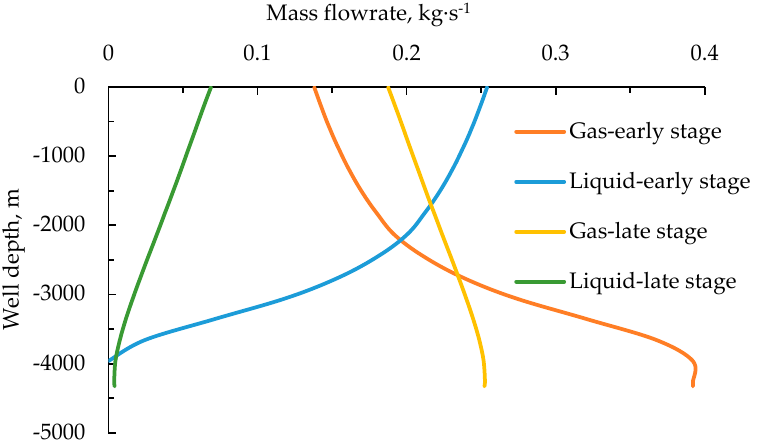
Figure 6. The mass flow rate in different periods.